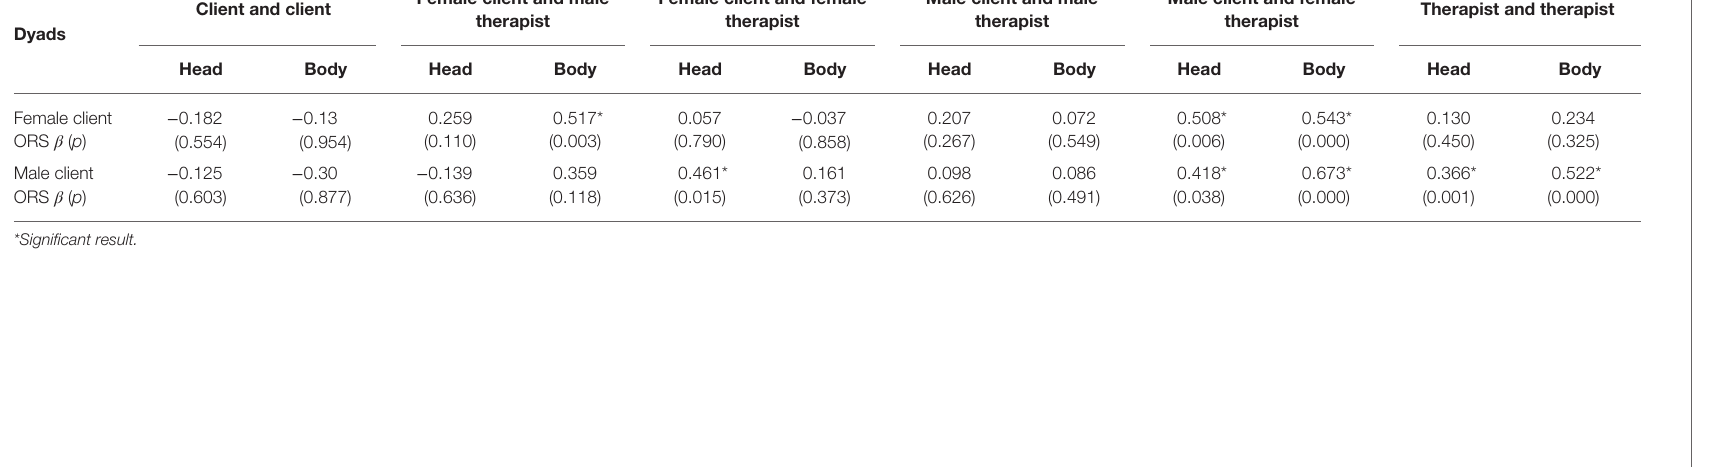
TABLE 7 | The relations between all participants’ Session Rating Scale (SRS) evaluations and head and body synchronies (ES noabs ).